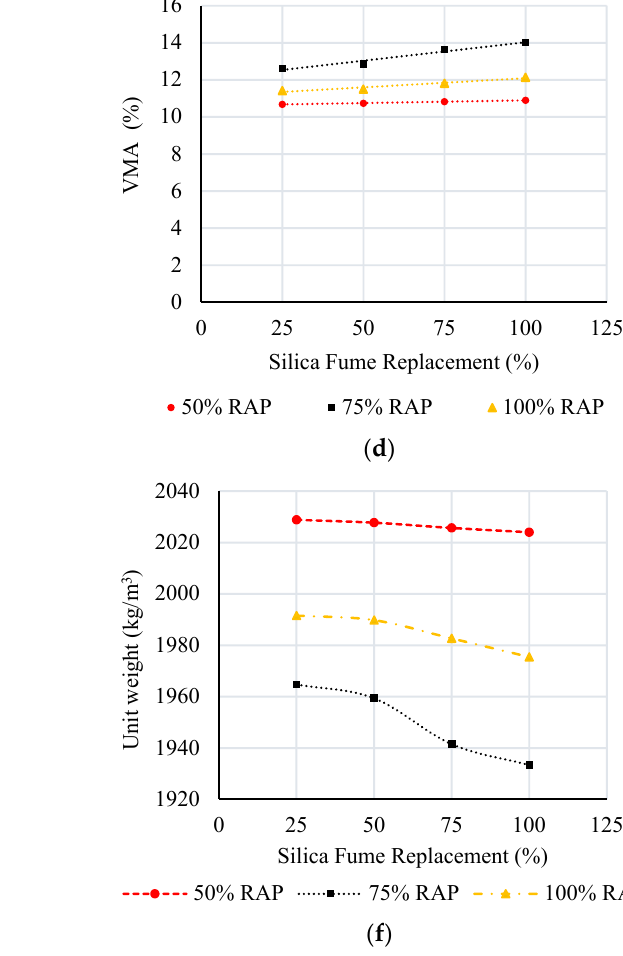
Figure 7. Test results of the three recycled aggregate mixes prepared with silica fume in terms of ( a ) Marshall stability; ( b ) flow; ( c ) unit weight; ( d ) air voids; ( e ) VMA; ( f ) VFA. Table 7. Test results for the RAP mixes containing silica fume.